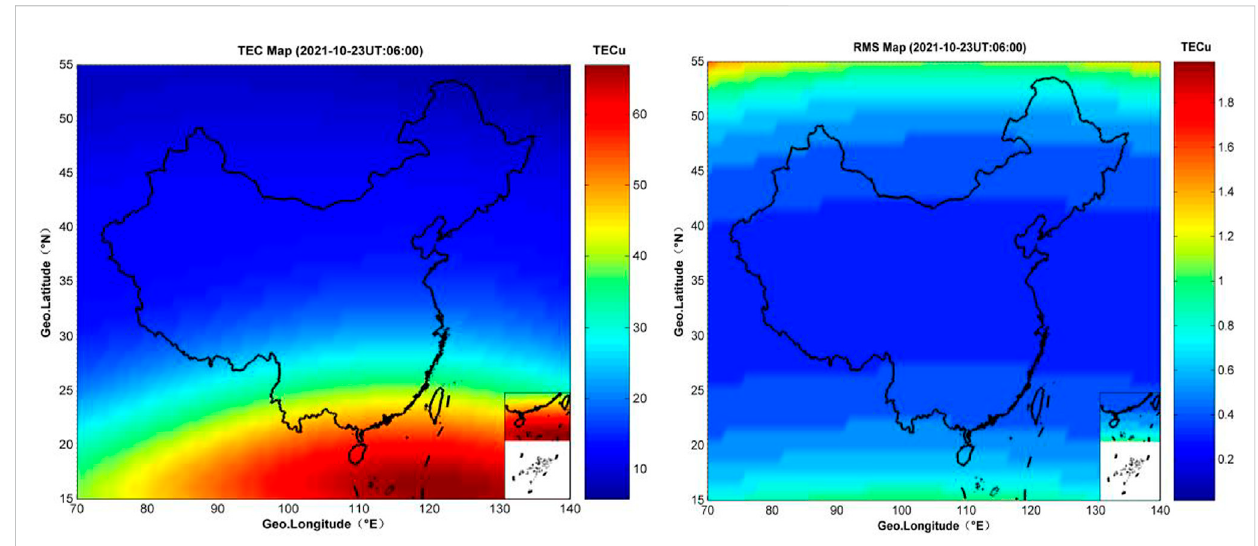
FIGURE 2 The spatial distribution of the TEC and RMS of the RIM (2021-10-23 UT0600), the x -axis and y -axis represent geographic longitude and latitude, respectively, and the color scale indicates the magnitude of TEC and RMS in